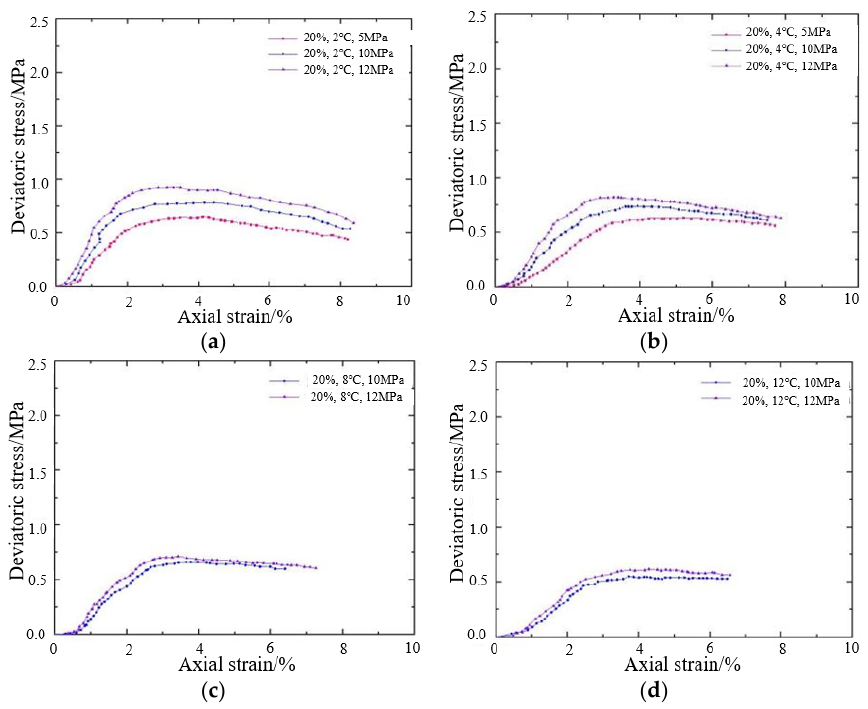
Figure 13. Core stress–strain curves at different pressures (abundance 20%) ( a ) The test temperature is 4 °C; ( b ) The test temperature is 4 °C; ( c ) The test temperature is 8 °C; ( d ) The test temperature is 12 °C.